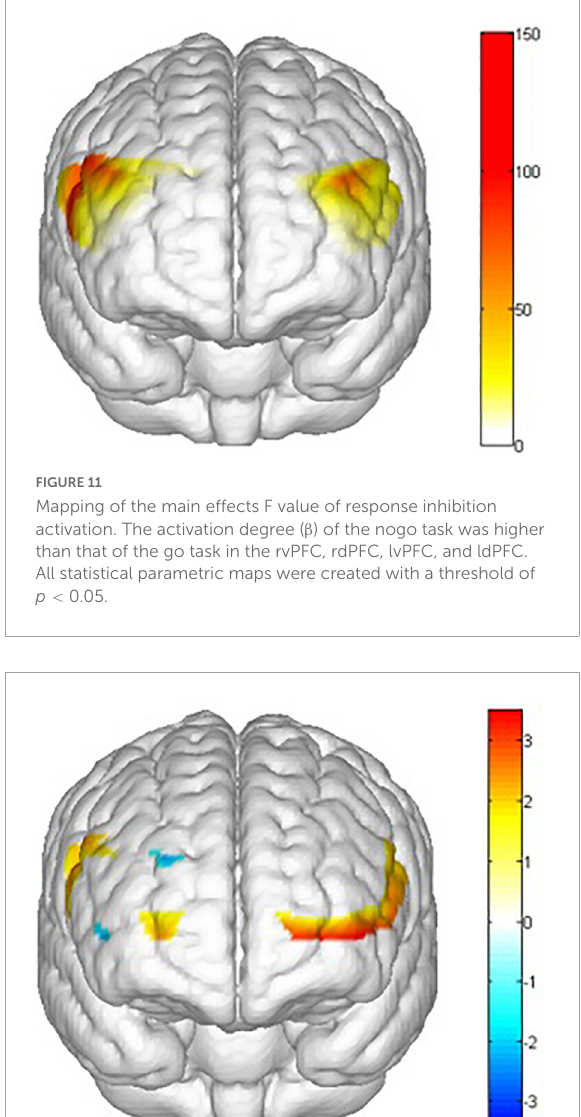
FIGURE12 Main effects t value of training conditions activation by comparing control condition and summer conditions (blank > summer). All statistical parametric maps were created with a threshold of p < 0.05.